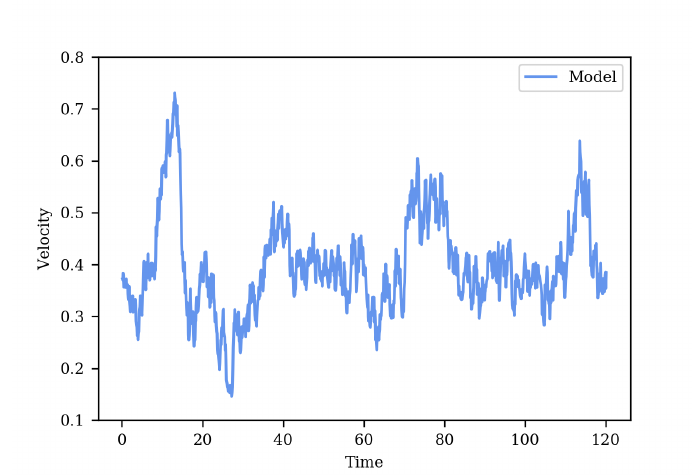
Figure 8. Regenerated velocity obtained from the Langevin model.